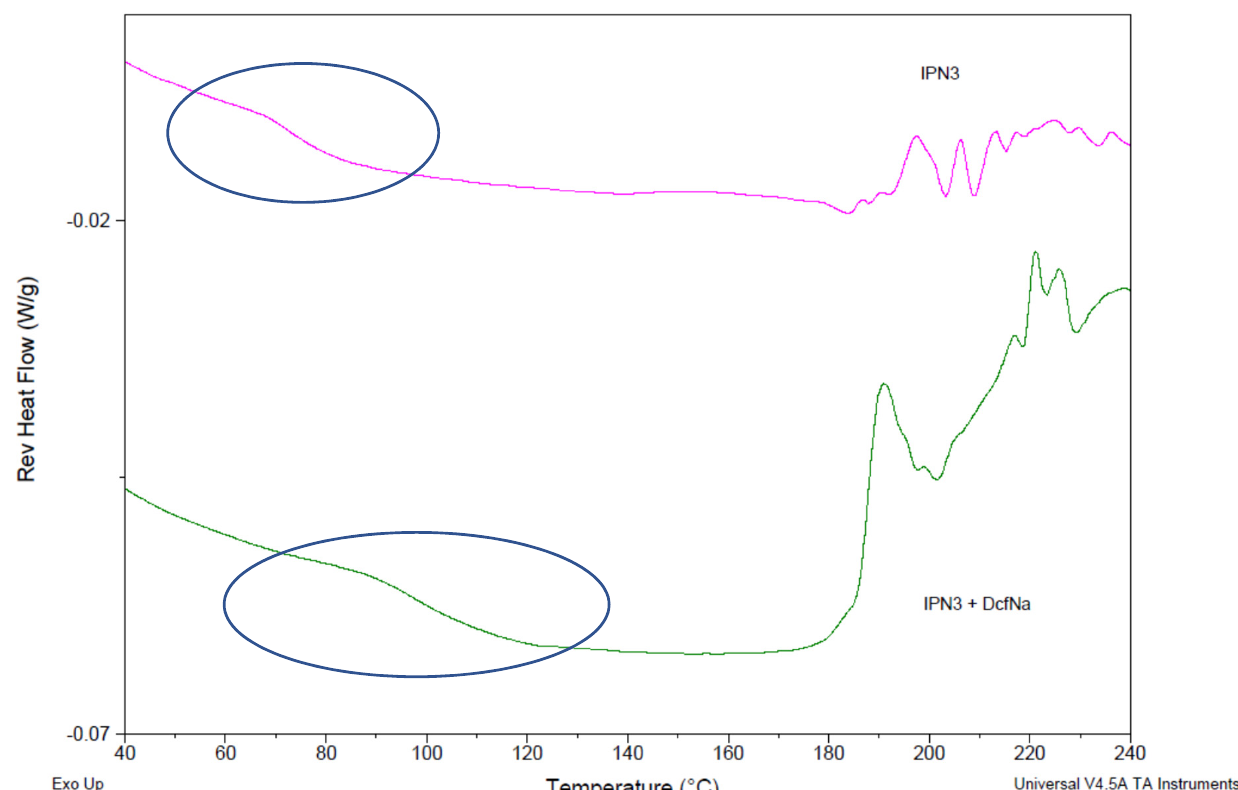
Figure 9. Reversing heat flow of IPN3 ( φ PDMAEMA = 0.46) without (red line) and with loaded diclofenac sodium (blue line).